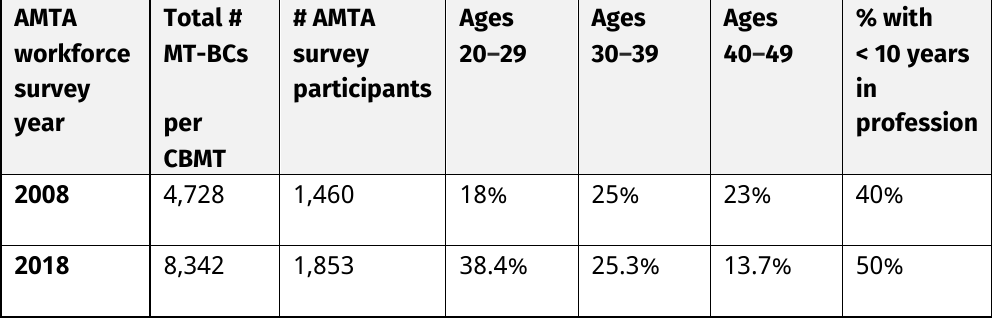
AMTA collects and publishes music therapy workforce survey data each year from AMTA members and non-members. This data is provided voluntarily by survey respondents and includes self-reported salary, number of years in the profession, age of respondent, average number of hours worked each week, job title or role, and work setting. Historically, fewer than 50% of all MT-BCs in the U.S. complete the survey, and only a percentage of those respondents complete each question. In 2008, there were 5,246 MT-BCs recorded by CBMT. In that year, 30%, or 1,460, individuals completed the AMTA workforce survey (AMTA, 2009). In 2018, there were 8,342 MT-BCs recorded by CBMT; 22%, or 1,853 individuals completed the AMTA workforce survey. This low response rate for the workforce survey indicates a significant gap in the workforce